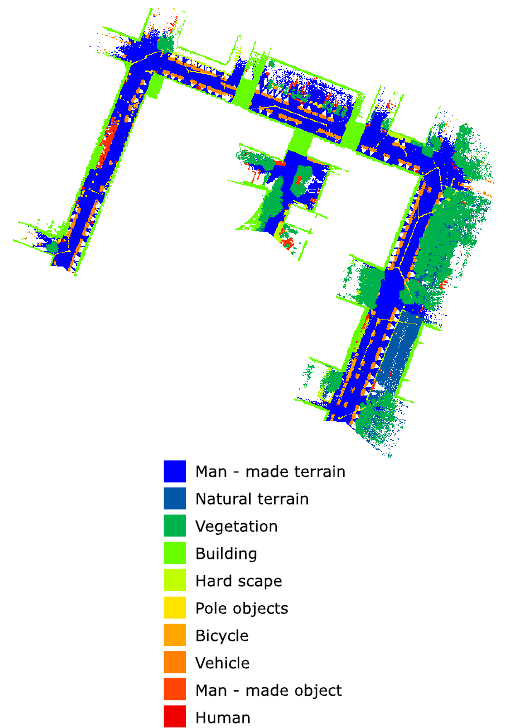
Figure 7. Training data used for training the RF classifier: part of the Luisenstrasse, Theresienstrasse and part of the